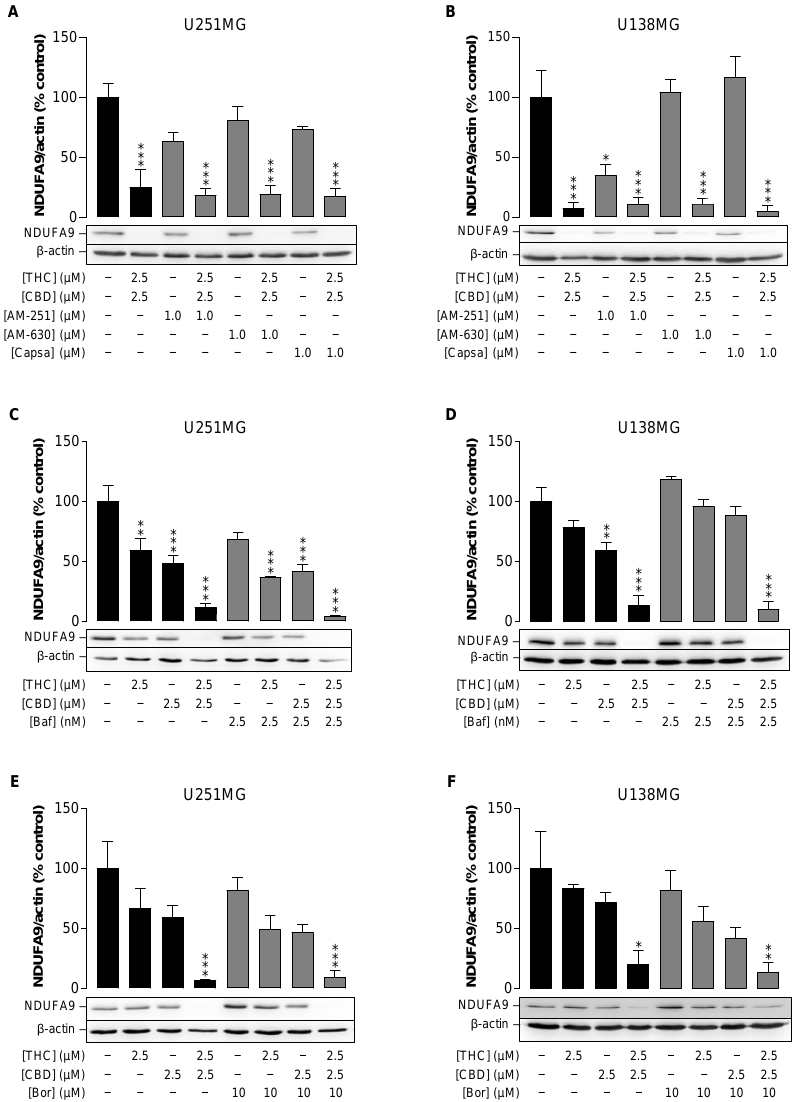
Figure 5. Role of cannabinoid-sensitive receptors ( A , B ), autophagy ( C , D ) and the proteasome ( E , F ) in downregulation of the mitochondrial subunit NDUFA9 by the combination of THC and CBD in human glioblastoma cells. U251MG and U138MG cells were incubated with selected concentrations of THC and CBD, their combination (in a ratio of 1:1) or vehicle control for 24 h. The receptor antagonists AM-251, AM-630 and capsazepine (1 µM each; panels ( A , B )) were applied to the cells 1 h before the cannabinoids and inhibitors of autophagy (bafilomycin A 1 , 2.5 nM; panels C and D ) or proteasome (bortezomib, 10 nM; panels ( E , F )) were applied together with the cannabinoids. Antagonists and inhibitors were present throughout the incubation with the cannabinoids. Subsequently, cellular total protein extracts were analysed for NDUFA9 levels by Western blots. All percentage values shown refer to the vehicle control, which was set to 100%. The values shown in the bar charts are based on densitometric analyses of blots, whereby the NDUFA9 levels were normalised to β-actin. The blots shown are representative. The data in all panels are mean values ± SEM of n = 3 independent experiments per group. * p ≤ 0.05, ** p ≤ 0.01, *** p ≤ 0.001 vs. corresponding vehicle control, one-way ANOVA with Bonferroni’s post hoc test.